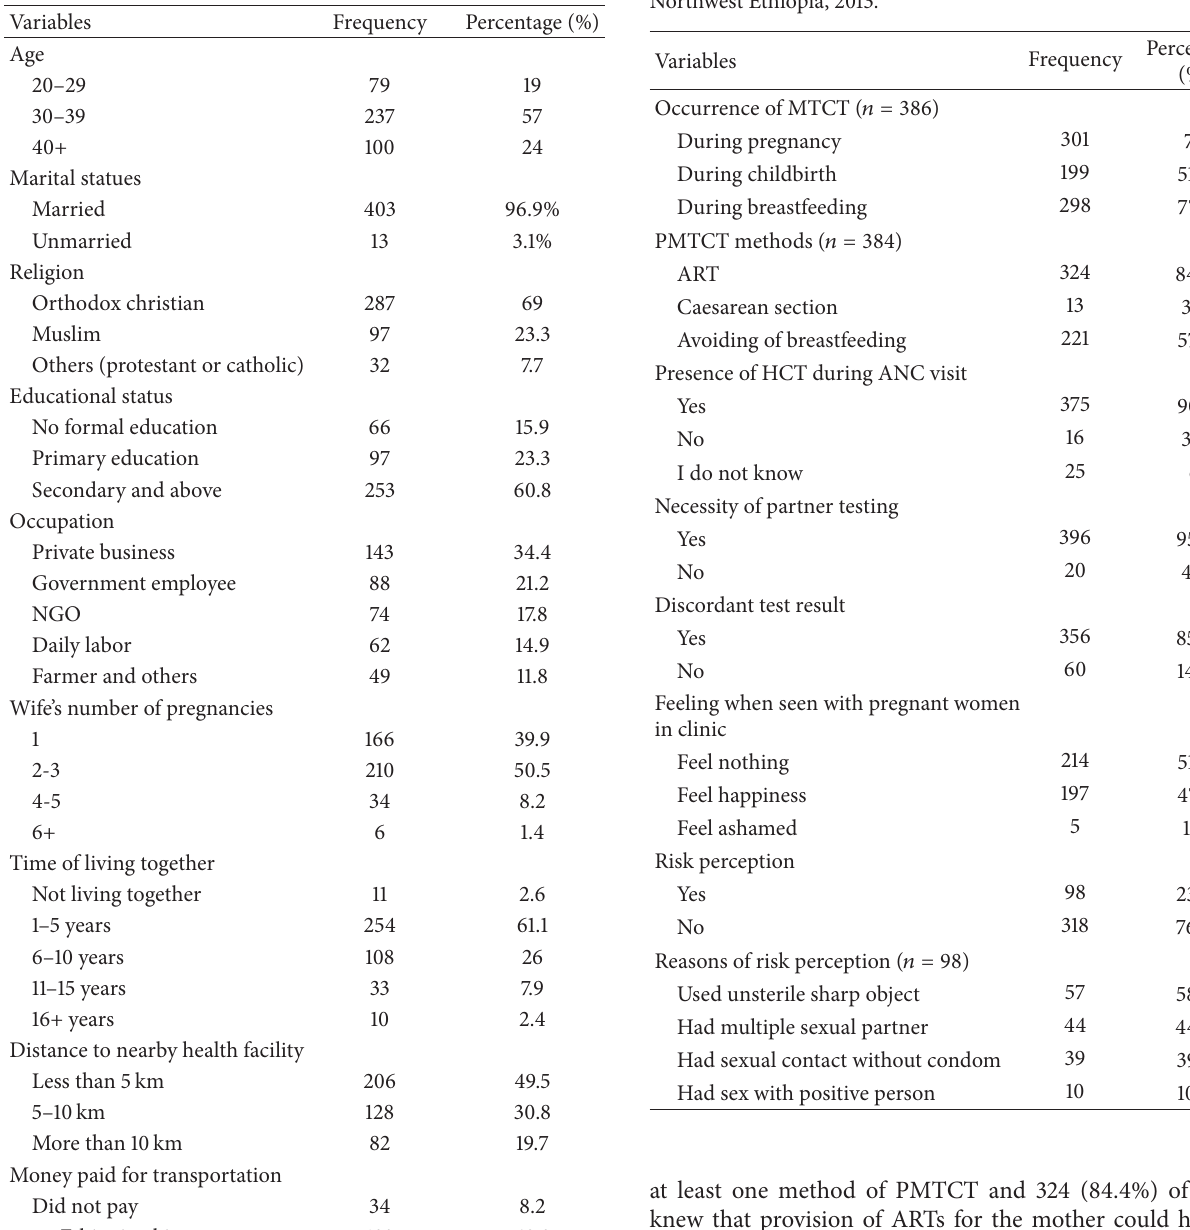
Table 1: A sociodemographic characteristic of partners of pregnant women in Gondar town, Northwest Ethiopia, 2013.